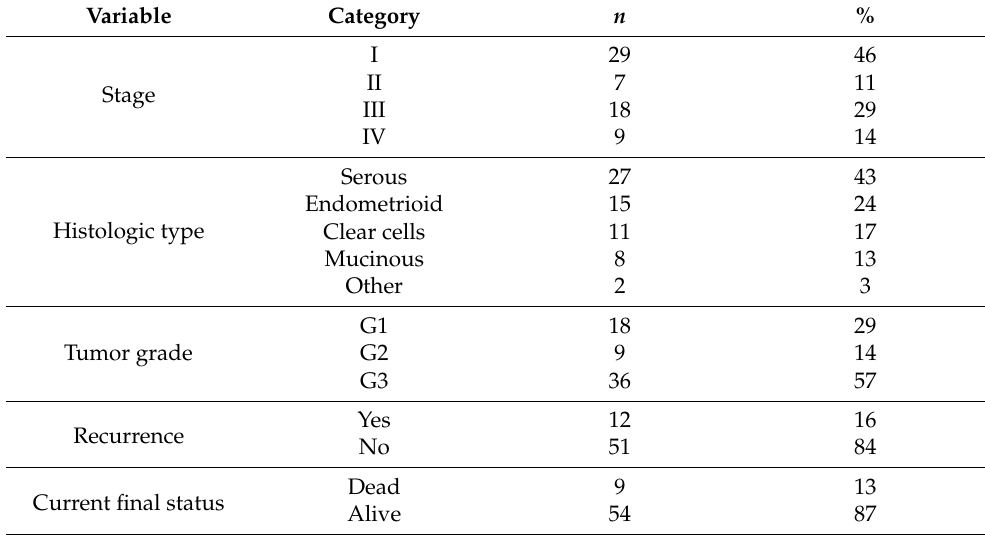
Table 1. Clinical characteristics of patients with ovarian carcinoma enrolled in this study.